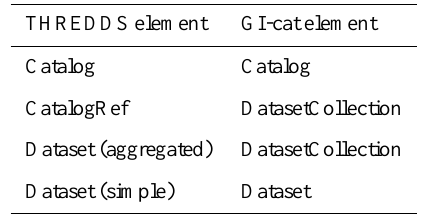
Fig. 7. THREDDS/OPENDAP Catalog tree strategy for improving query performance. Figure 7: THREDDS/OPENDAP Catalog tree strategy for improving query 2 Table 1. CDI elements mapping onto GI-cat ones.